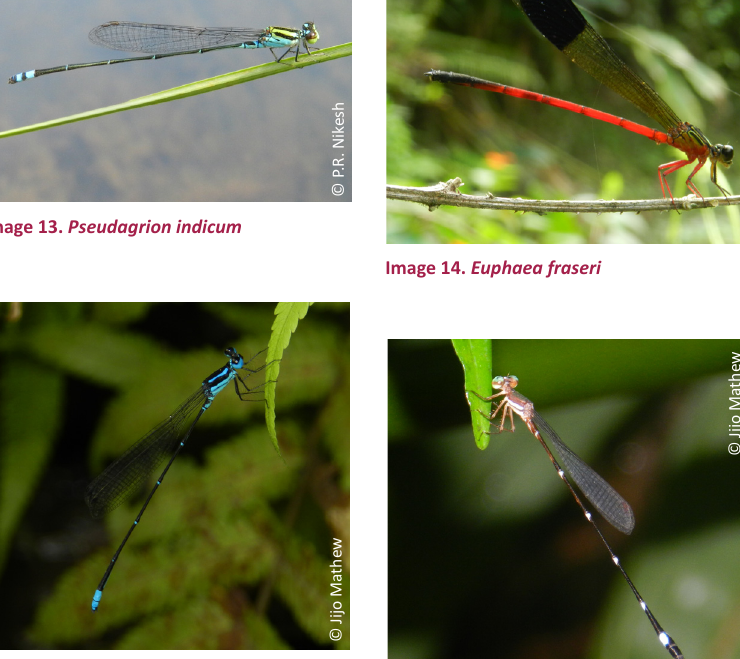
Image 16. Caconeura risi